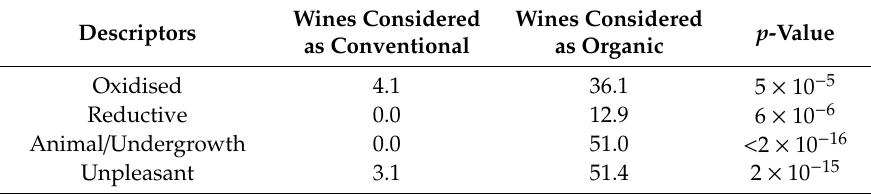
Table 9. Frequency of citations of sensory descriptors and emotional response elicited by wines considered to be conventional or